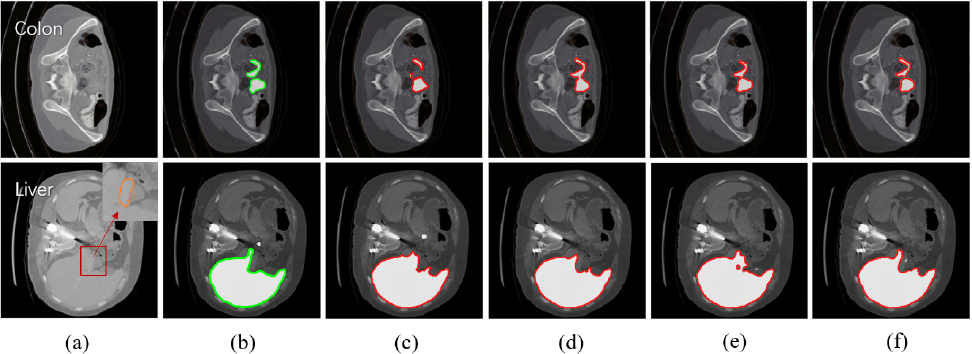
Figure 7. Subjective measures of different approaches in the established segmentation scenarios (top: colon, bottom: liver). Each row presents one typical task, from left to right: ( a ) raw scans; ( b ) ground truth labels; ( c ) pipeline II (multi-source Training); ( d ) MAML + layer-freezing; ( e ) Reptile + layer-freezing; ( f ) ours + layer-freezing. White areas represent the image features of colon and liver.